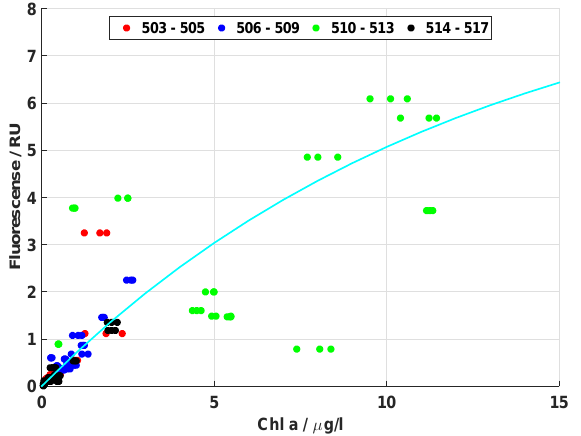
Figure 6. Left: comparison between SPM and turbidity measure- ments from the CTD casts. The cyan line represents Eq. (7). Right: comparison between backscatter signal at 700nm from the profiler and turbidity data from the CTD as well as correlation be- tween the two measurement systems (cyan line). Red and blue dots represent stations in Uummannaq Fjord; green dots are stations in Vaigat and black dots are stations in Disko Bay.